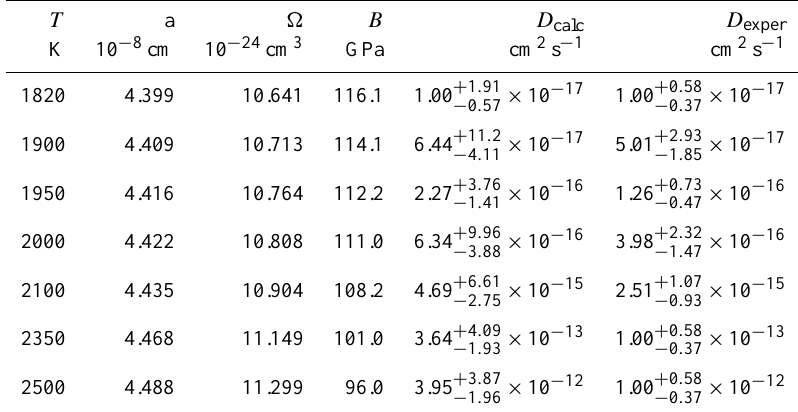
Table 1. The values a, (cid:127) , B , calculated ( D calc ) and experimental ( D exper ) diffusion coefficients along with their errors for the temperature range (1820–2500) K and for c ( 1820 ) =